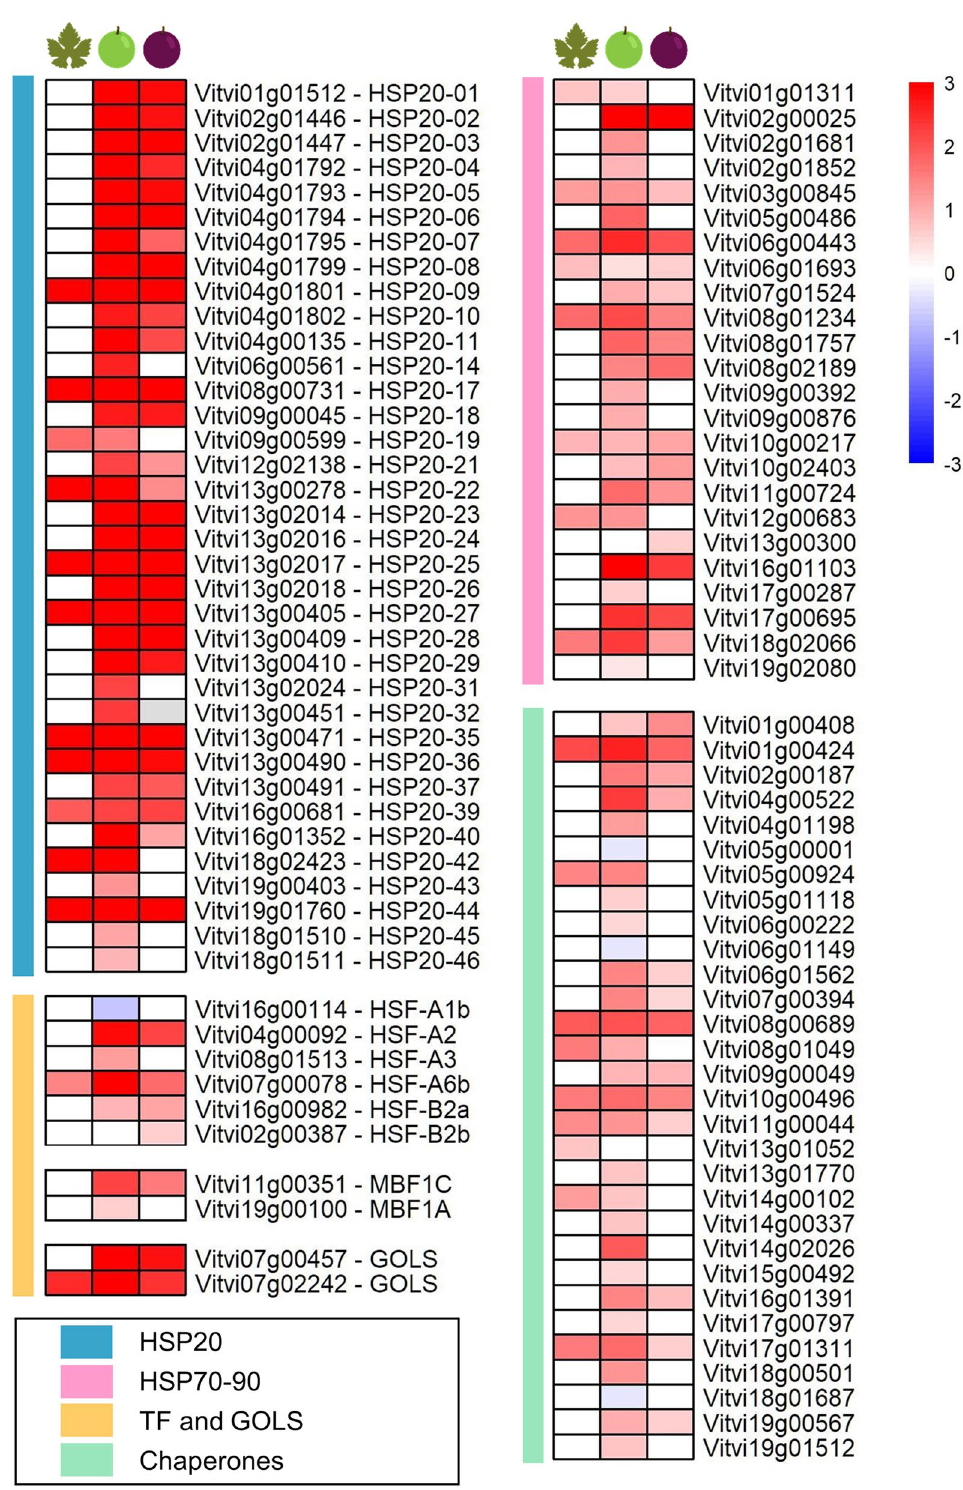
Figure 4. Heat-shock proteins, chaperones and related transcription factors modulated by the ozonated water treatment in leaves (left column), berries at the beginning of ripening (middle column) and berries in mid- ripening (right column) are represented in heatmaps as log 2 FC(OW/C). Red and blue colours indicate up- or down-regulation, respectively. The coloured sidebar on the left displays the class of